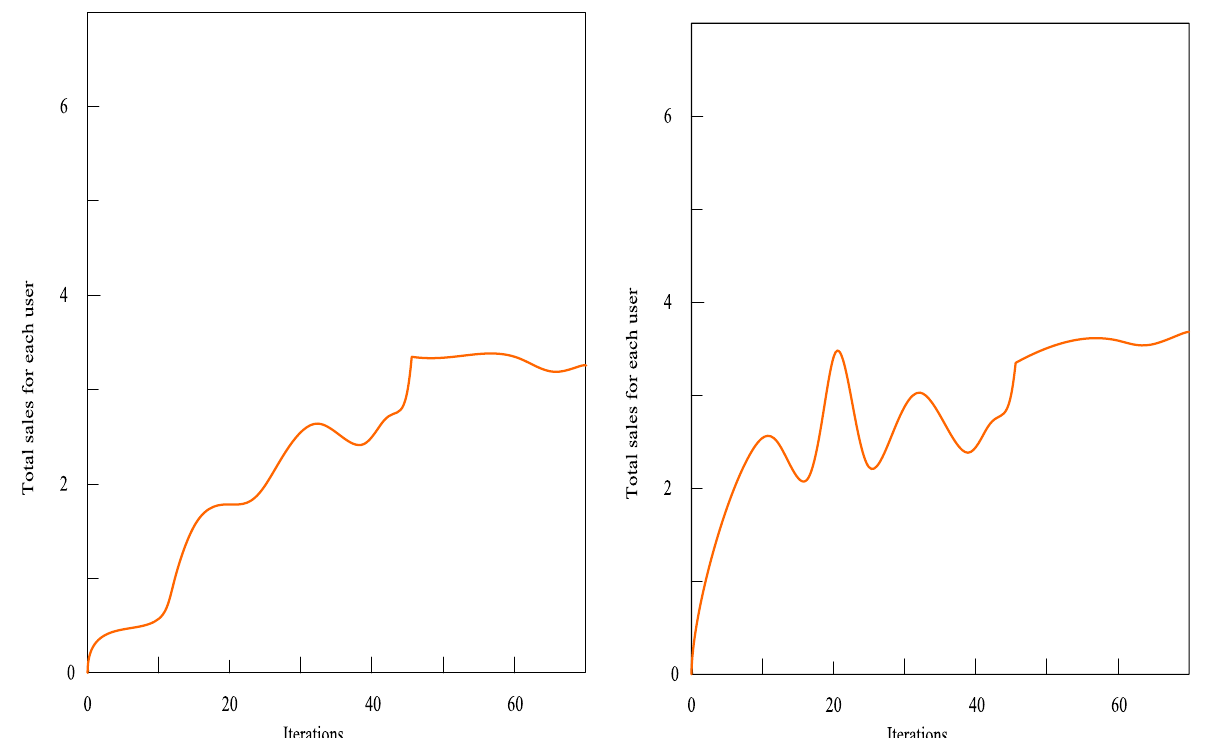
Fig. 8 Change graph of individual user calculation overhead [ a Figure of 20 individual users. b Computational cost variation plots for 40 individual